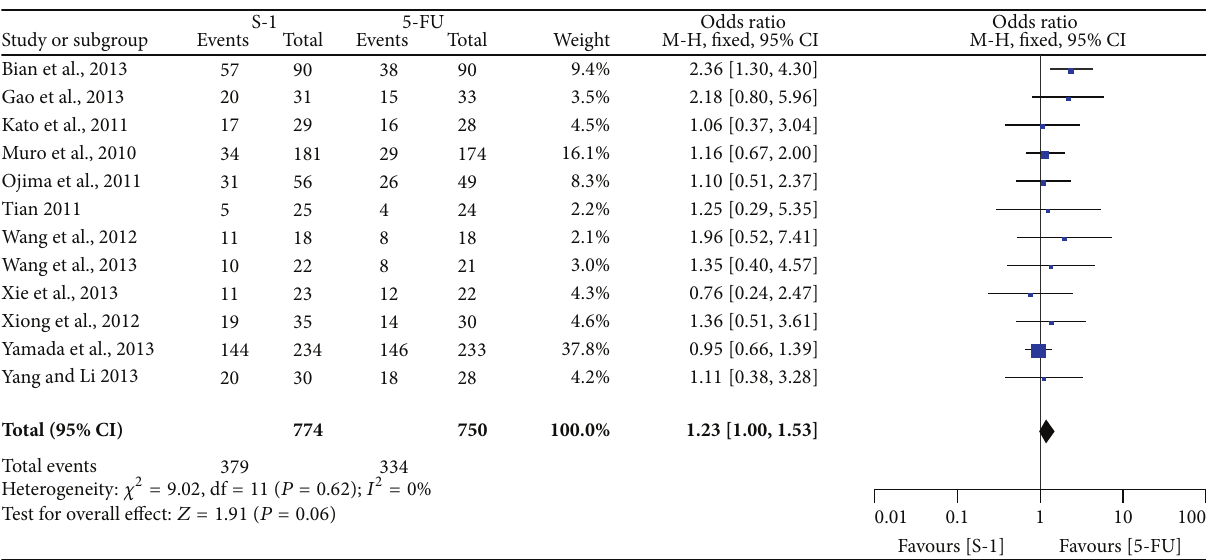
Figure 7: Forest plot of odds ratio of overall response rate.